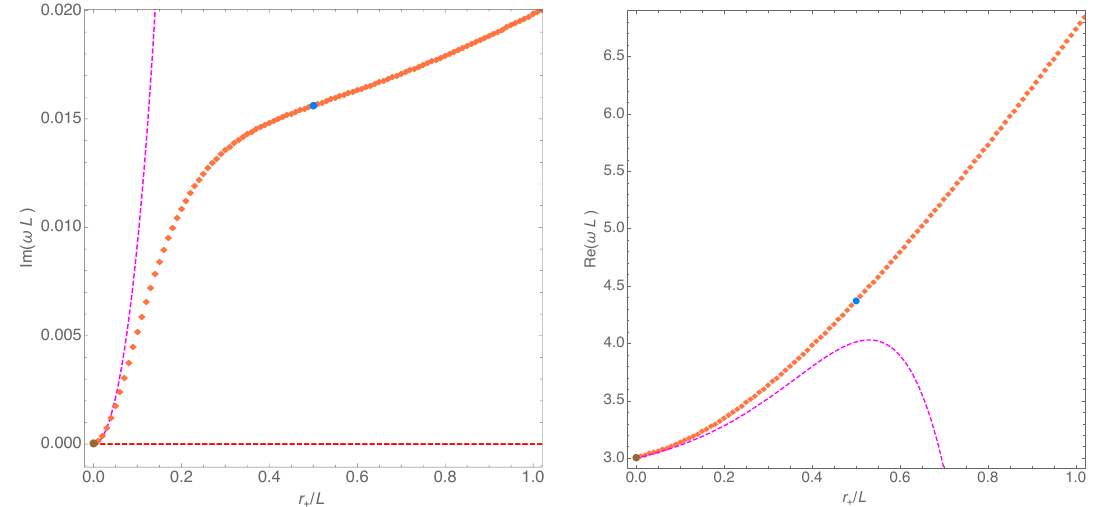
Figure 3 . Scalar (cid:12)eld frequency as a function of the dimensionless horizon radius r + =L for a AdS- RN black hole with (cid:22) = 0 : 99 (cid:22) ext and qL = 2 : 5 that is always above the near-horizon bound (3.7) ( mL = 0 and ‘ = 1). Left panel : Imaginary part of the dimensionless frequency, Im( !L ). Right panel : Real part of the dimensionless frequency, Re( !L ). In both plots, the magenta dashed curves describe the analytic prediction of the perturbative expansion in r + =L about AdS. The unstable modes are thus connected to the AdS normal modes when r + ! 0 (brown disk). For reference, the blue disk with r + =L = 0 : 5 is shown (which makes contact with (cid:12)gure 2).